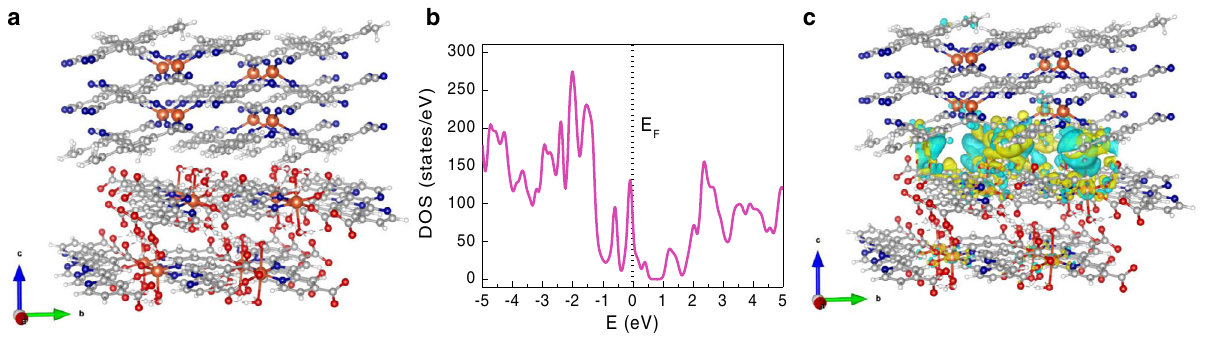
Fig. 6 | Probing electronic structure of the interface by DFT calculations. a EnergyoptimizedstructureoftheinterfaceinvolvingCu-TCNQ(top)andphase-I of Cu-BPyDC (bottom) where carbon, hydrogen, nitrogen, oxygen, and copper atoms are represented by colors gray, white, blue, red, and orange, respectively (view from bc plane). b Total density of state (DOS) for the interface structure